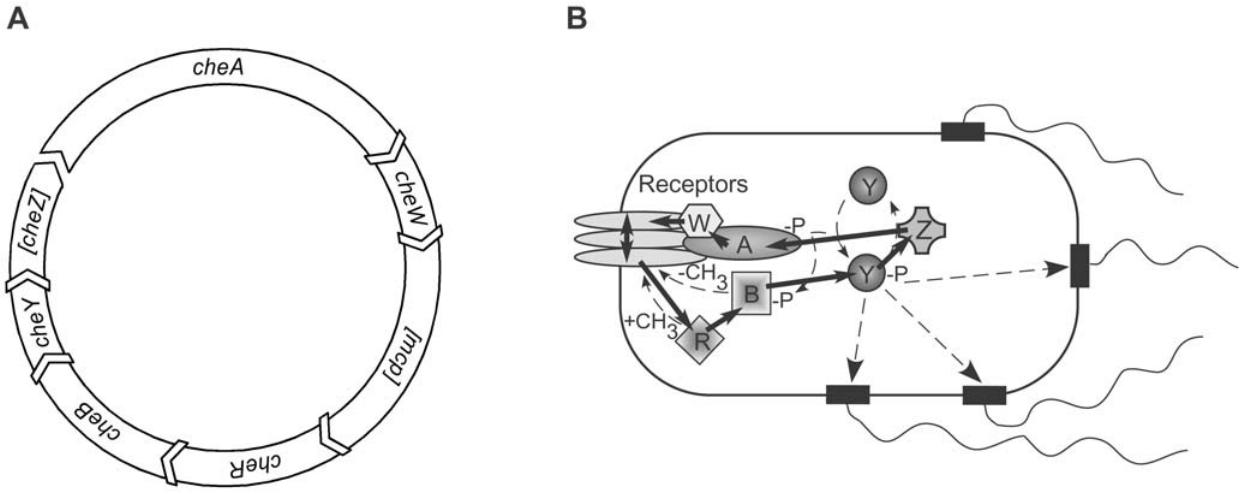
Figure 5. Genetic coupling of chemotaxis genes in bacteria. (A) Preferential order of pairwise chemotaxis gene coupling among analyzed bacteria. Receptor ( mcp ) gene is shown in brackets because the number of receptor genes between cheW and cheR is variable; cheZ is shown in brackets because it is only present in a subset of bacteria. See Table 1 and Tables S2 and S3 for the frequencies of relative occurrence. (B) Genetic coupling (solid arrows) among chemotaxis proteins shown for E. coli pathway. Thin dashed arrows denote pathway reactions and CheY-P binding to flagellar motor.